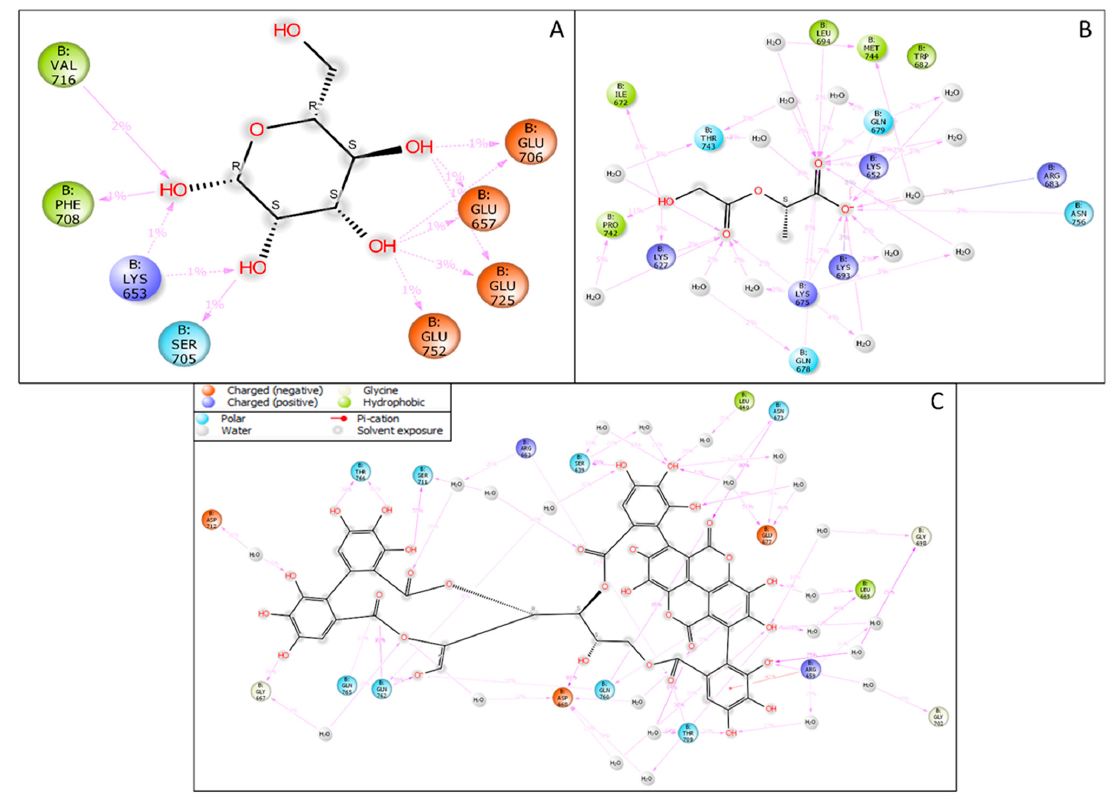
Figure 7. The interaction during the simulative periods among the macrophage mannose receptor in complex with ( A ) mannose, ( B ) PLGA, and ( C ) punicalagin.